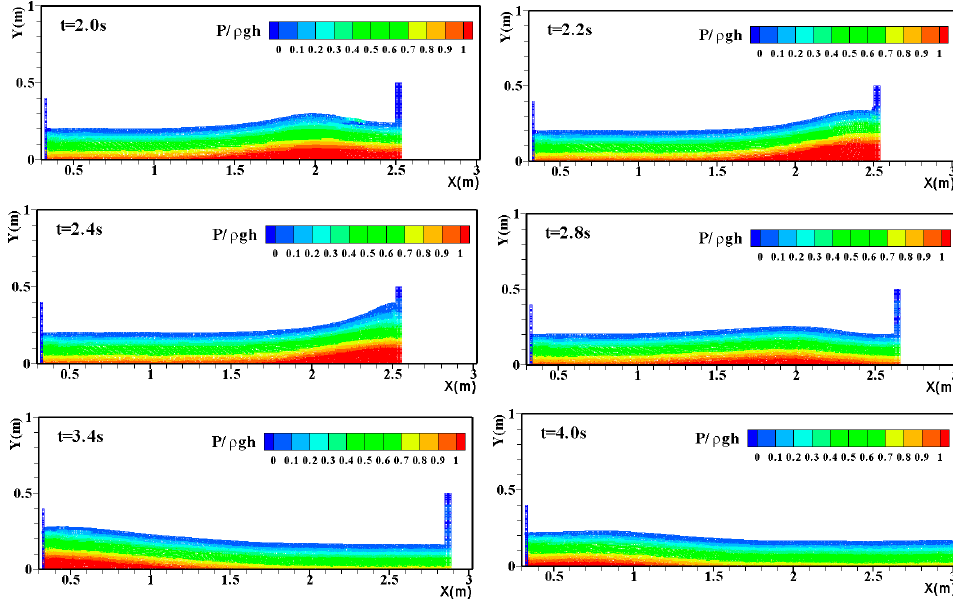
Figure 14. Schematic sketch of the wave surface profiles.